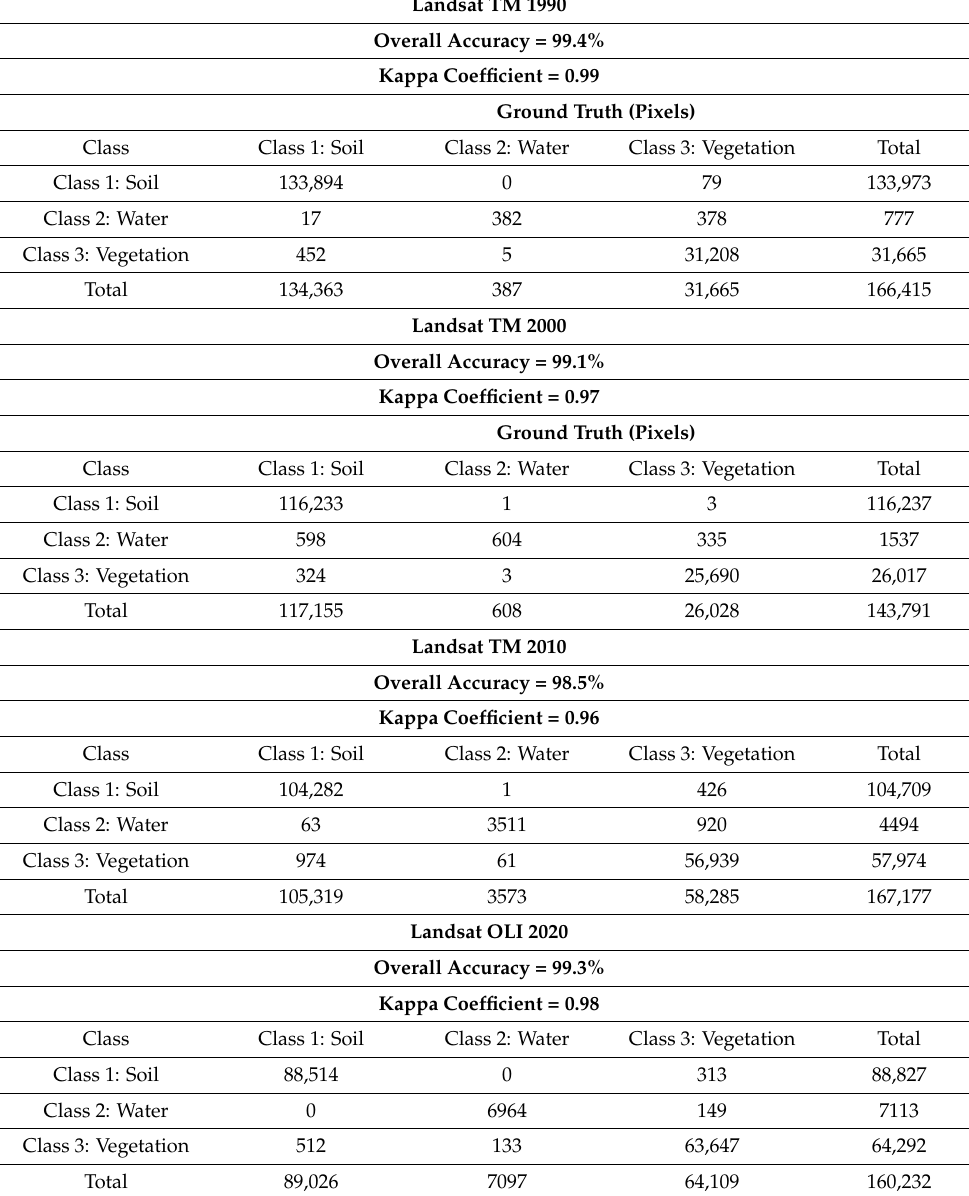
Table 3. Summary of accuracy (%) and kappa statistics of Landsat NDVI and NDWI